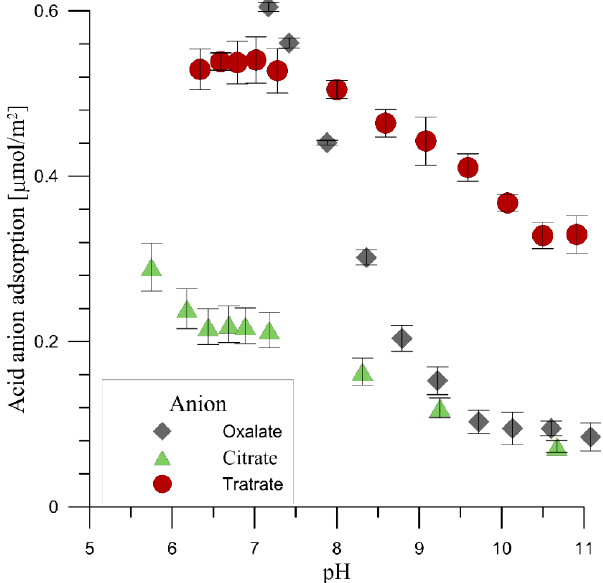
Figure 4. Oxalate, citrate and tartrate ion adsorption in the hydroxyapatite/0.001 mol/dm 3 NaCl solution system as a pH function. The initial concentration of oxalate, citrate or tartrate ions was 0.001 mol/dm 3 .